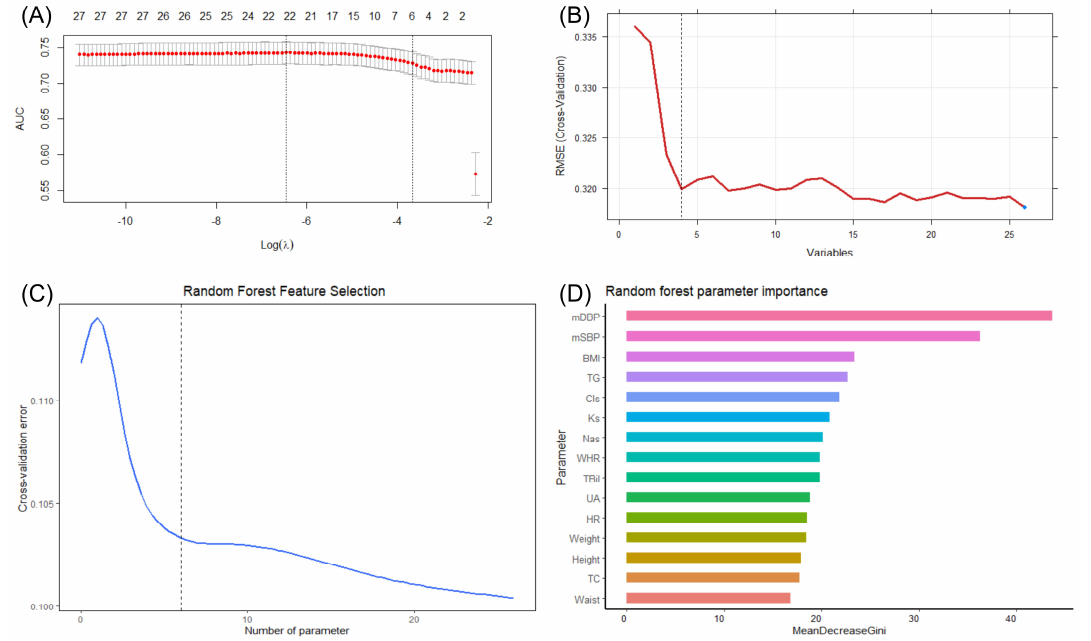
Figure 2. Machine learning feature selection strategies in this study. ( A ) LASSO regression analysis. Six features were identified including SBP, DBP, BMI, triglyceride, heart rate and diabetes. ( B )